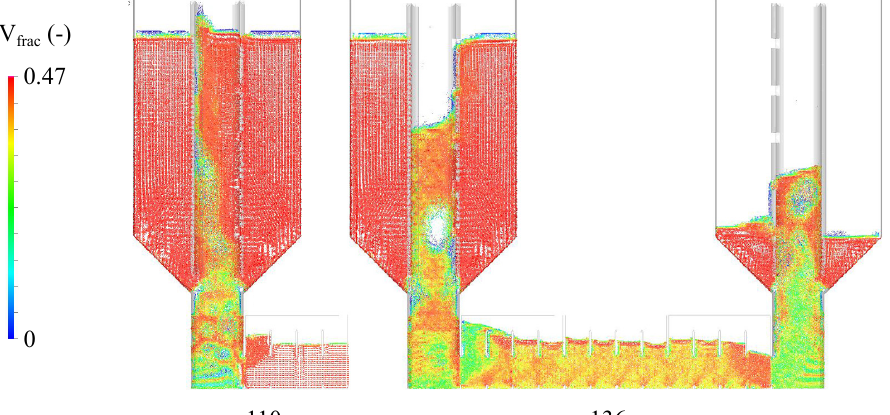
Figure 14. Pipe 3—start-up and transport, V frac = 1 − ψ —break-through in left hand side hopper at 110 s, sand is flowing through orifices at 136 s [20].